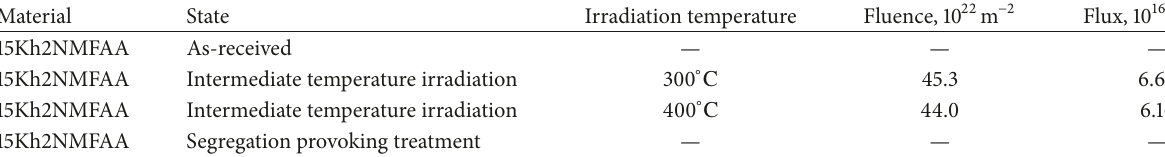
Table 2: The studied states of the material.